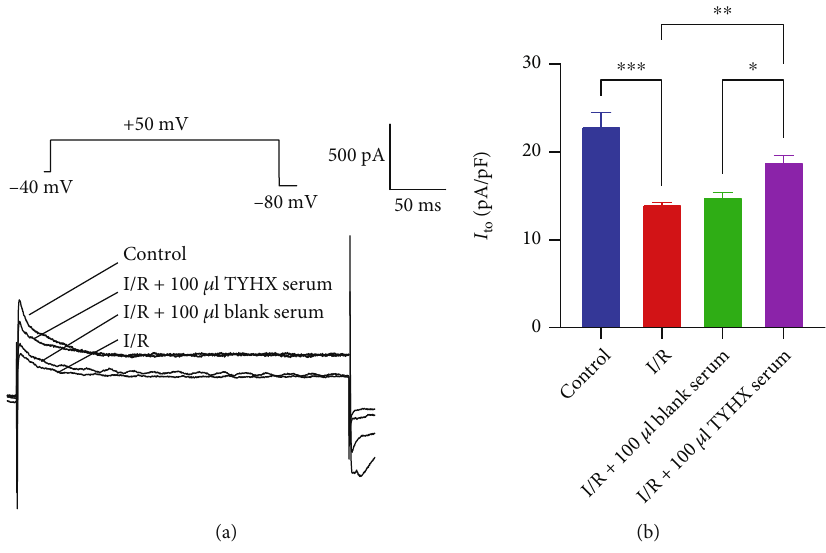
Figure 1: The e ff ect of TYHX on the peak current of I